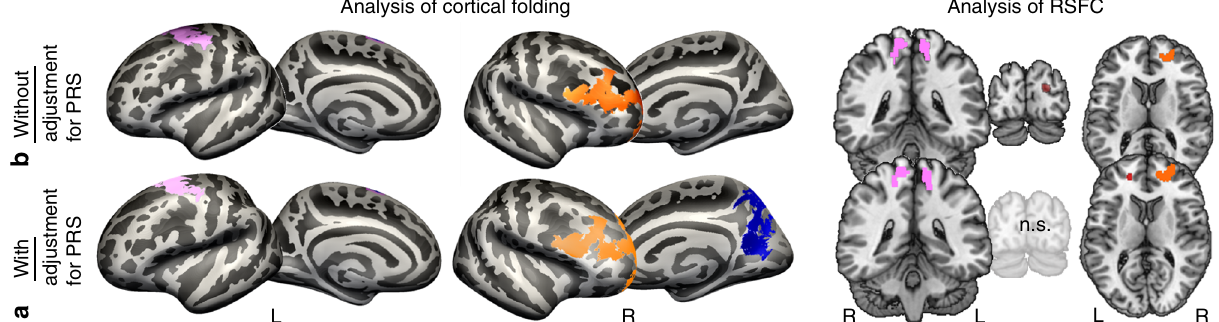
Fig. 5 Comparison of analyses without adjustment for polygenetic risk scores (GRS) and with adjustment for polygenetic risk score (PRS). a The lower row shows the results of the analyses of cortical folding and resting-state functional connectivity (RSFC) with adjustment for PRS. b The upper row shows the results of the analyses of cortical folding and RSFC with adjustment for PRS. Whereas the general pattern of the results did not change after adjustment for PRS, an additional decrease in cortical folding in right precuneus was observed. n.s. = not signi fi cant, L = left hemisphere, R = right hemisphere